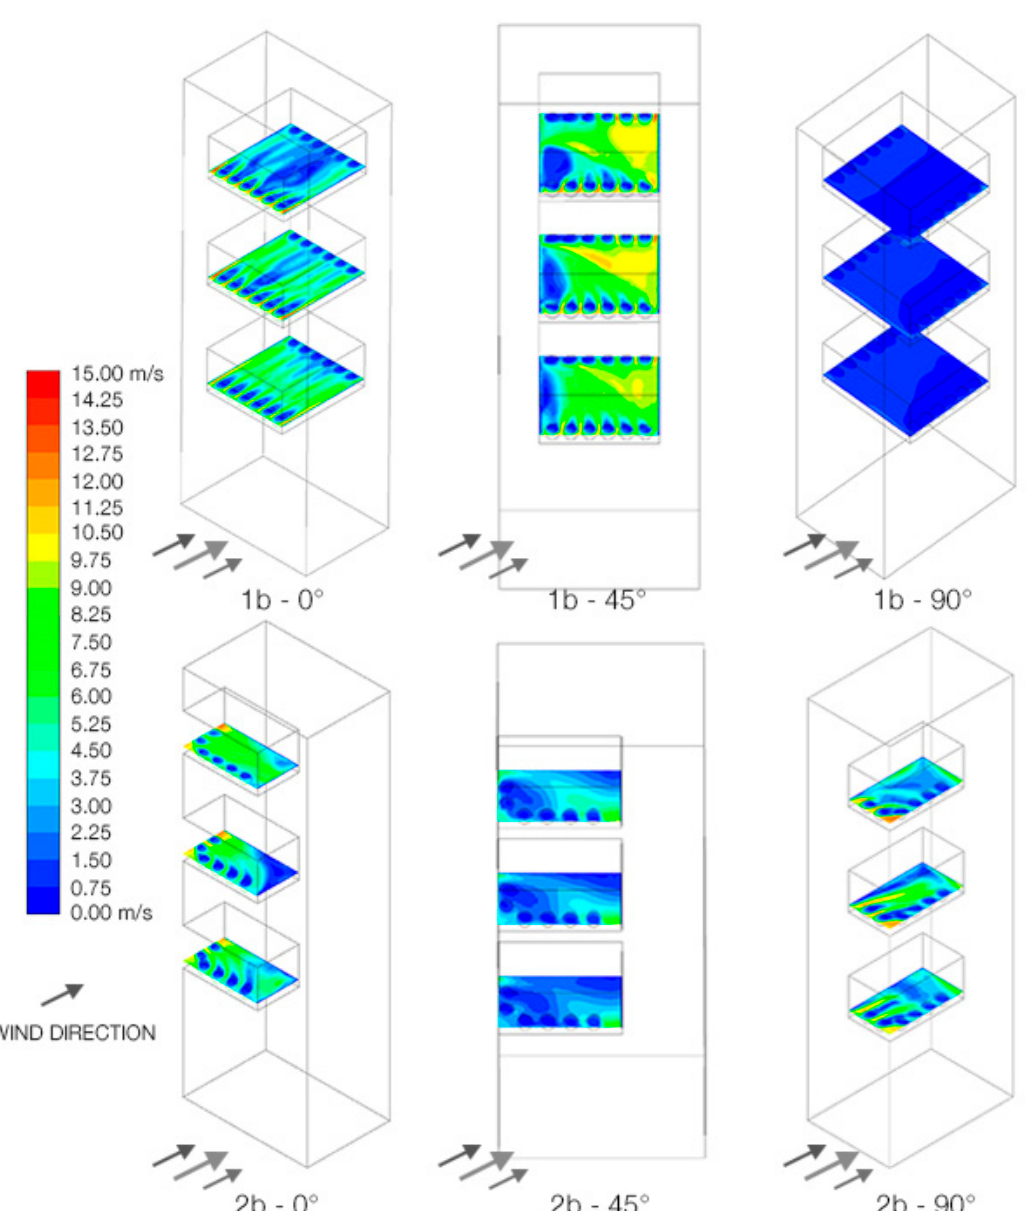
Figure 18. Velocity gradient at sky gardens with trees with oblique wind direction; (1a) Central sky garden b/B = 0.4, (1b) Central sky garden b/B = 0.6, (1c) Central sky garden b/B = 0.8, (2a) Corner sky garden b/B = 0.4, (2b) Corner sky garden b/B = 0.6, (2c) Corner sky garden b/B = 0.8, (3a) Periphery sky garden a/A = 0.5.